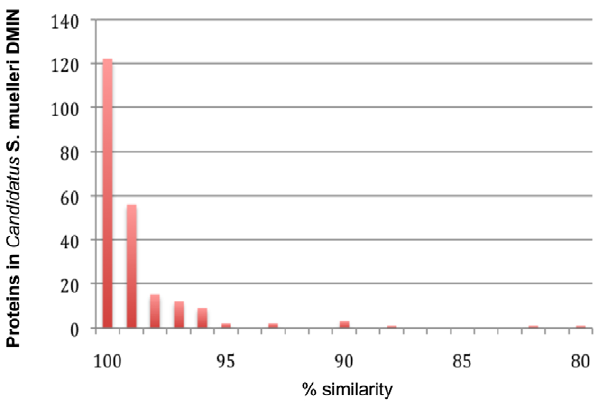
Figure 2. Distribution of protein similarities between the two available genomes of Candidatus Sulcia muelleri from sharpshooters.